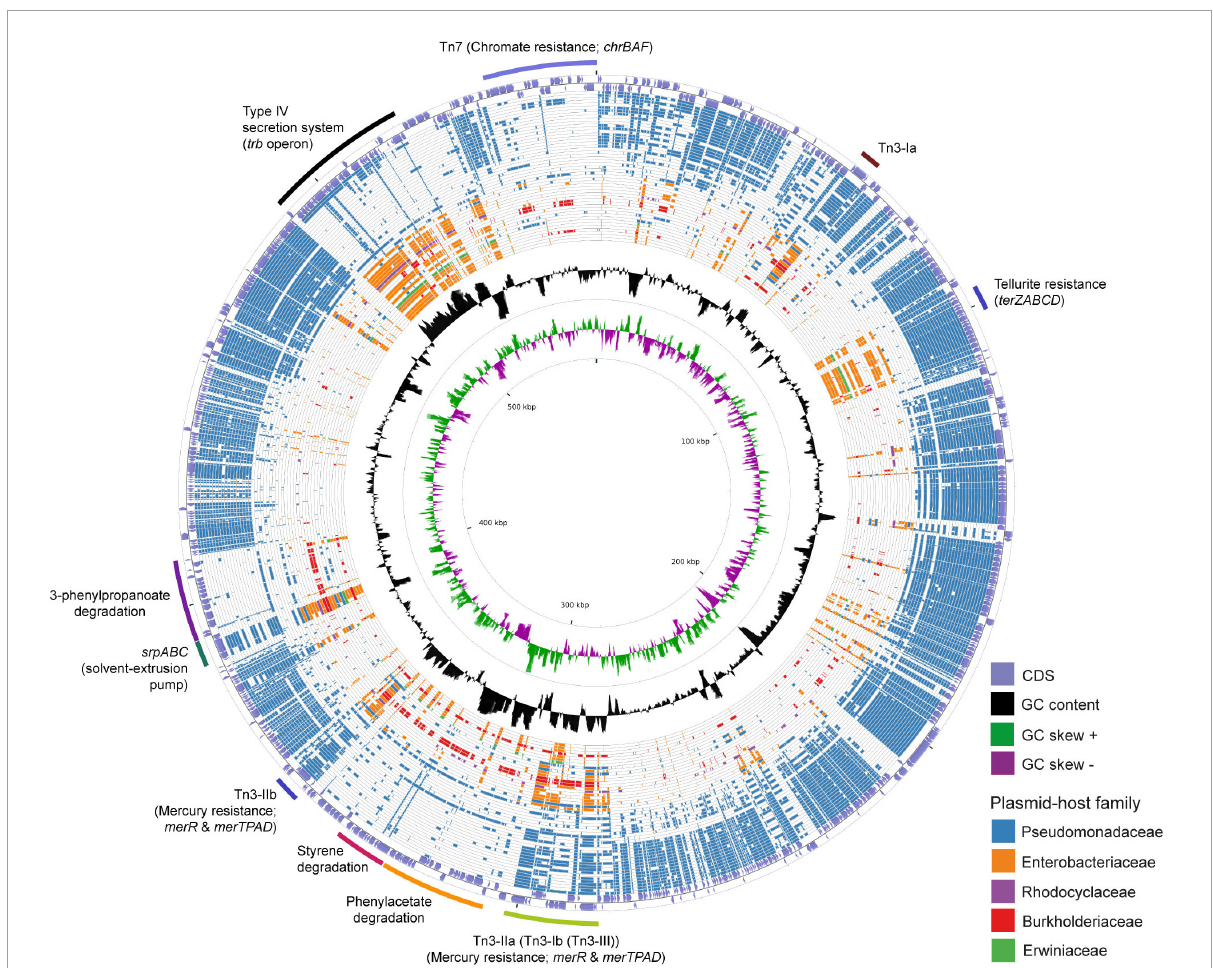
FIGURE1 Circular plot of the top 50 plasmids with the highest identity scores to pTTS12. pTTS12 coding sequences (CDS) were aligned to 28915 other plasmids available at NCBI Refseq and Nuccore databases. The outer light purple ring represents the CDS of plus and minus strand of pTTS12. In the inner ring, the GC content is represented in black and the positive and negative GC skew are represented in green and purple respectively. The plasmids are ordered based on their similarity and coverage to pTTS12 CDS from outermost to innermost of the plot with each ring representing a single plasmid as listed in Table 3 . In case no homologous protein was identified for a pTTS12 counterpart, that space on the circle was left blank. Ring colors represent different plasmid-host families; Pseudomonadaceae (blue), Enterobacteriaceae (orange), Rhodocyclaceae (purple), Burkholderiaceae (red), and Erwiniaceae (green). The position of the gene clusters of interest are annotated in the figure. An extended circular plot of the top 500 plasmids with highest identity scores to pTTS12 are shown in Supplementary Figure 1 .